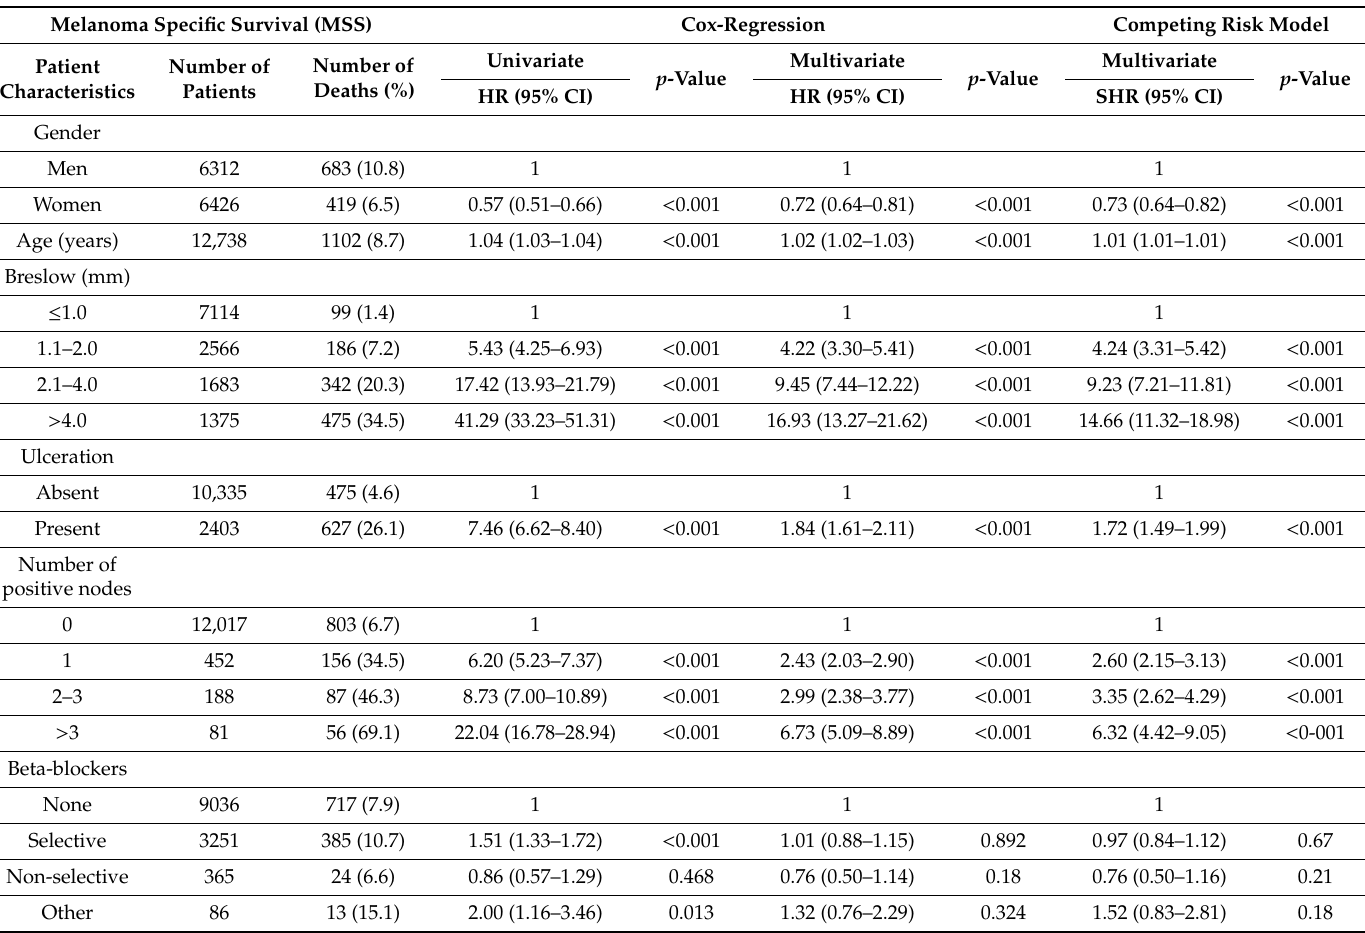
Table 2. Melanoma specific survival (MSS) and competing risks for the e ff ect of beta-blockers in patients with primary stage I–III cutaneous melanoma diagnosed between 2009 and 2013 in